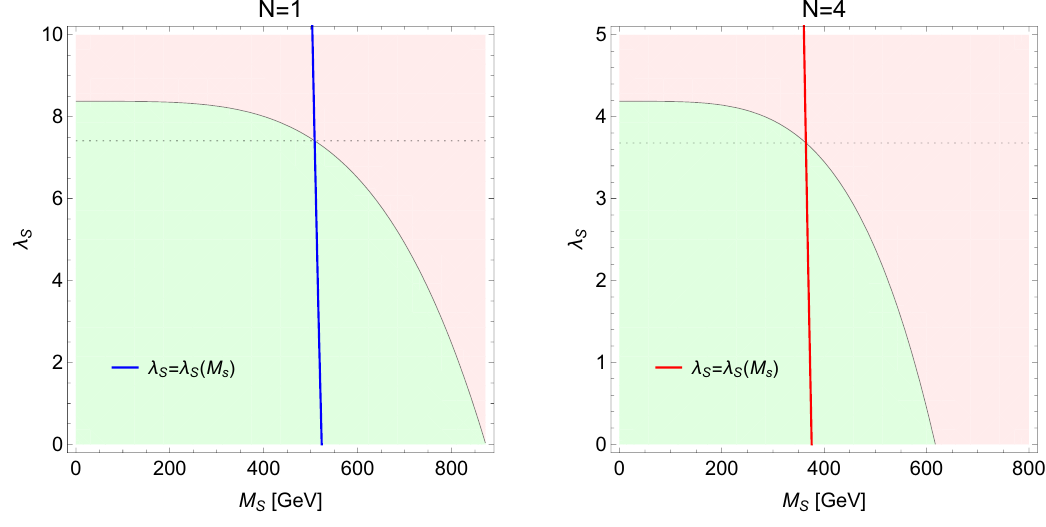
Figure 5 . Regions of the M S and λ S parameter space of the O ( N ) -symmetric CSI model allowed (light green) and excluded (light red) by the requirement of tree-level perturbative unitarity — fol- lowing ref. [52]. Additionally, the blue and red curves give the values of λ S computed at respectively one and two loops using equation (3.11) as a function of M S . The left pane is for N = 1 , while the right one is for N = 4